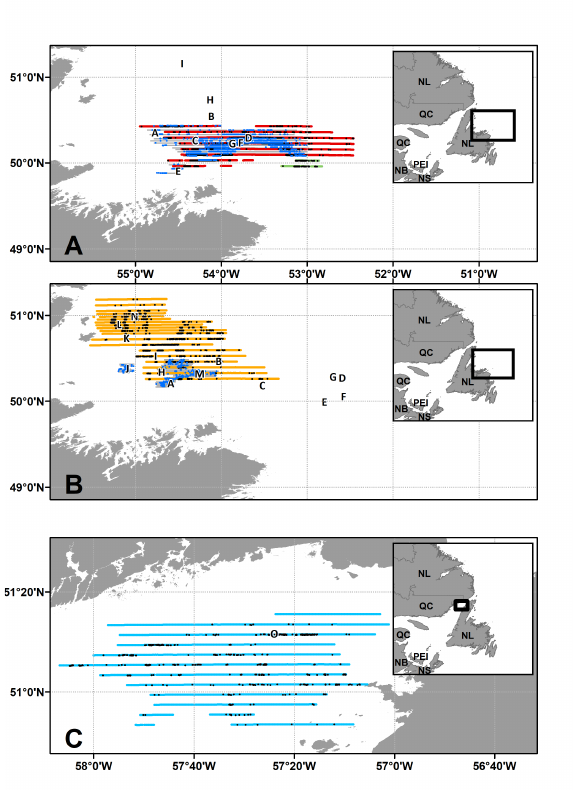
Figure 5. Survey transects of the Groais Island (A, 14 March), Strait (B, 18 March), and Northern Gulf (C, 17 March) whelping concentrations. Visual surveys are indicated by grey line while photographic surveys are in colour. The ‘northern’ Groais Island survey lines are red while the separate ‘eastern’ Groais Island transects are in green. Pups identified during visual surveys are shown in blue while pups identified on photographs are black. Letters refer to individual ice beacons to indicate